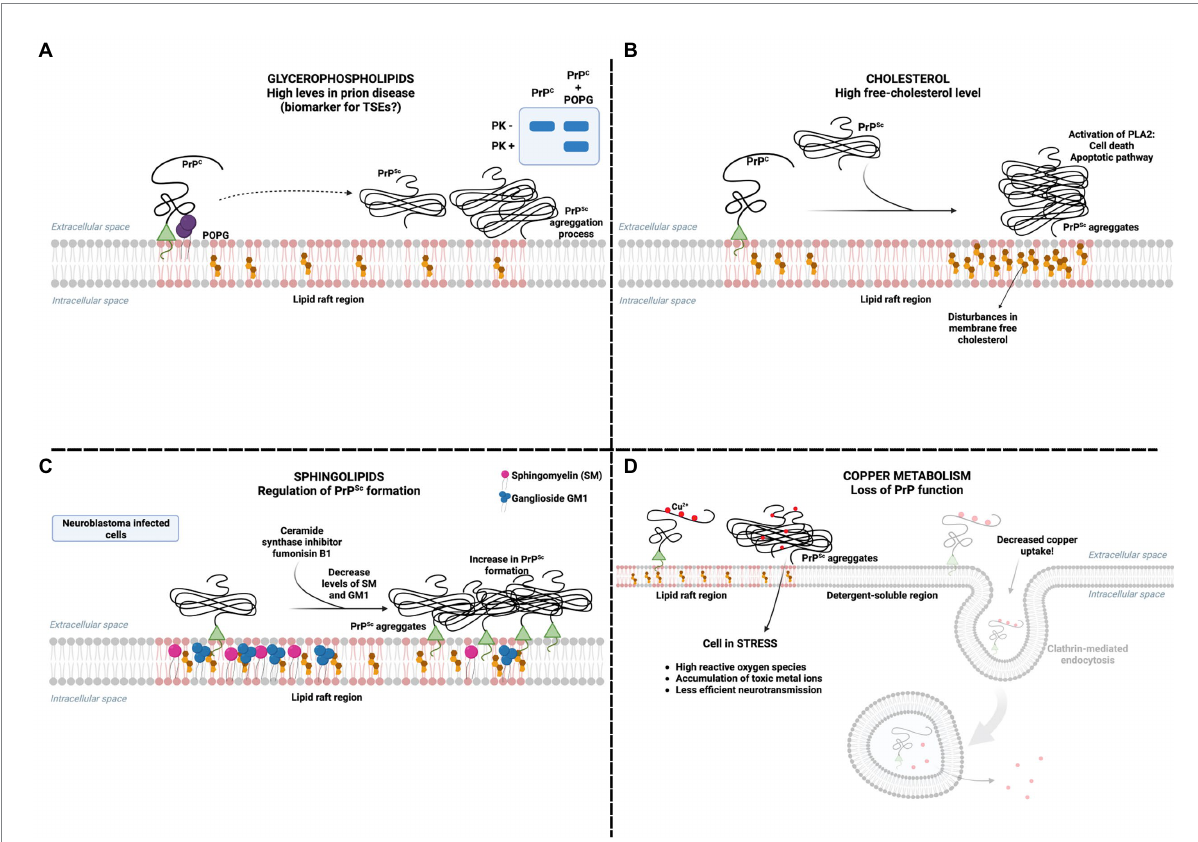
FIGURE 2 PrP C interaction with lipids in pathology (A) Glycerophospholipids are proposed as potential biomarkers for TSEs as their concentration increases in prion disease models. The interaction of PrP with POPG can modulate the formation of proteinase K-resistant PrP Sc aggregates. (B) It has already been reported that the presence of PrP Sc increases free cholesterol and activates cell death mechanisms by activating phospholipase A (PLA). (C) The presence of sphingolipids in the membrane is essential in inhibiting the presence of PrP Sc . Depletion of sphingolipids SM and GM1, using the ceramide synthase inhibitor fumonisin B(1), has been reported to increase the presence of PrP Sc in neuroblastoma cells infected with PrP Sc . (D) The presence of PrP Sc in the plasma membrane prevents the internalization of copper, promoting a series of harmful consequences to the cell, mainly related to oxidative stress. Created with